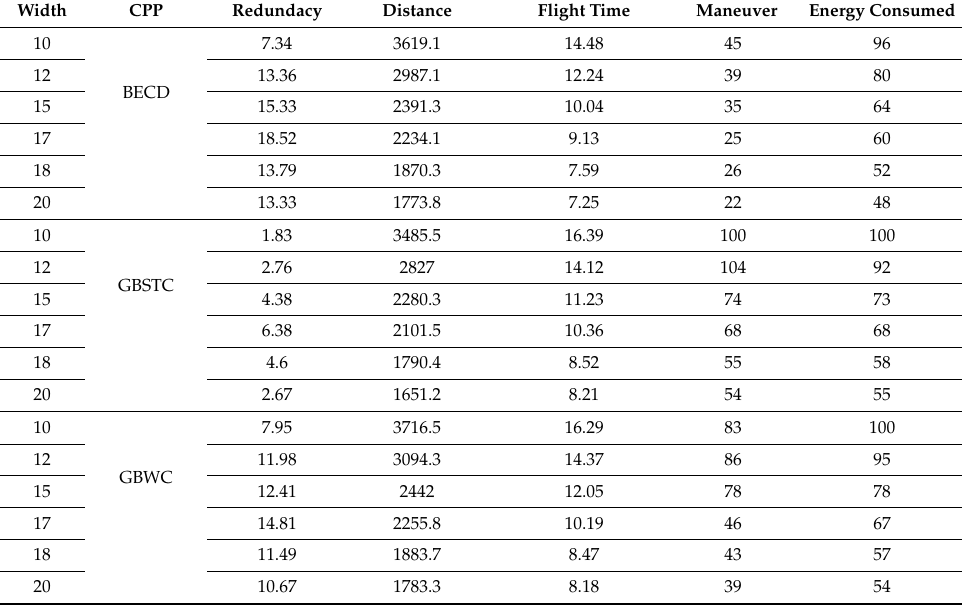
Table A6. Experiment 4 with three CPP methods implemented using UAV 3DR Iris over Unioeste 1 PV Plant.